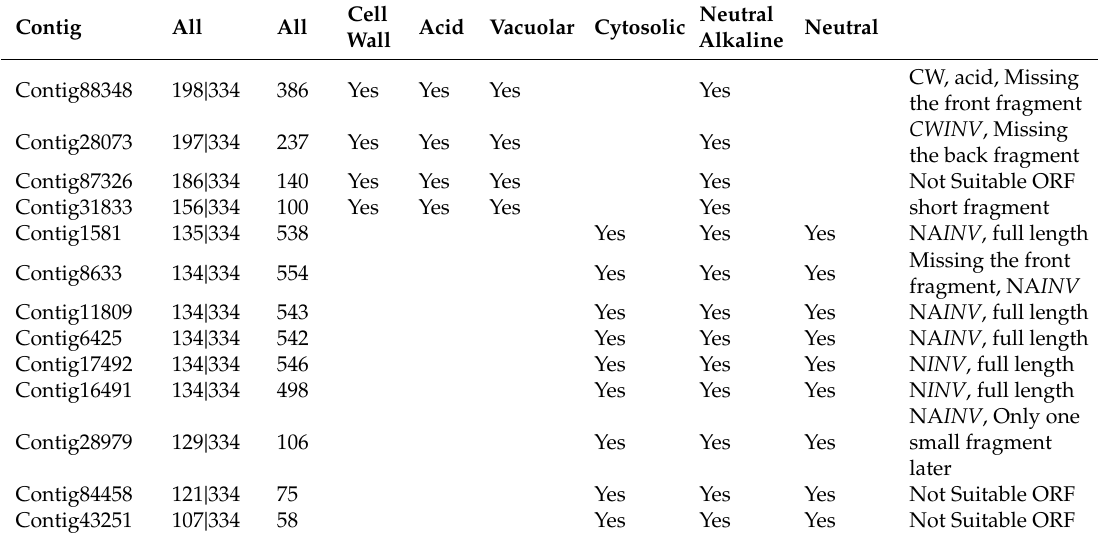
Table 1. INV genes evaluation